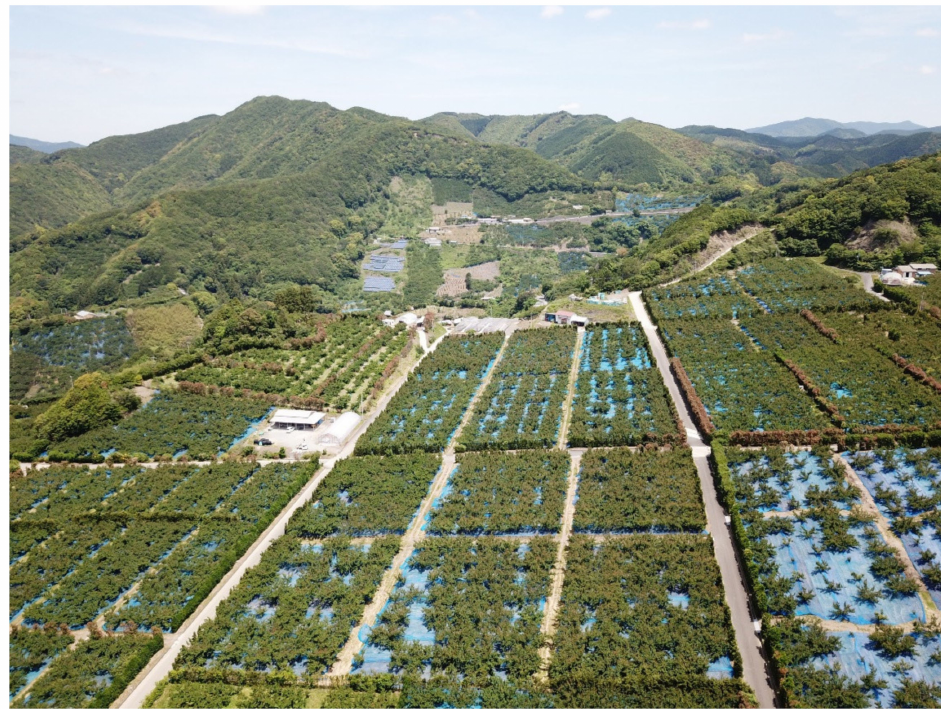
Figure 3. Drone image from the southern cut-fill sites (foreground) toward the northern traditional sloped sites (background) (acquired on 12 May